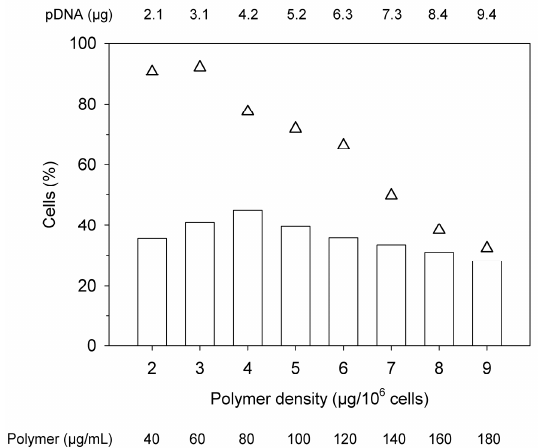
Figure 4. Optimization of the polymer density in high cell density (HCD) transfections of Jurkat cells. (Total cells: 5 × 10 6 cells, transfection volume 0.25 mL, bars represent the percentage of transfected cells, (cid:52) : viabilities, data represent the averaged values of one experiment carried out in duplicate. An N/P of 10 was adjusted in all experiments.).